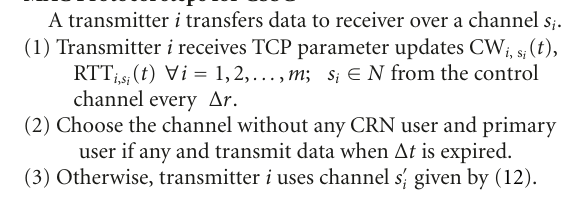
MAC Protocol steps for CSSG